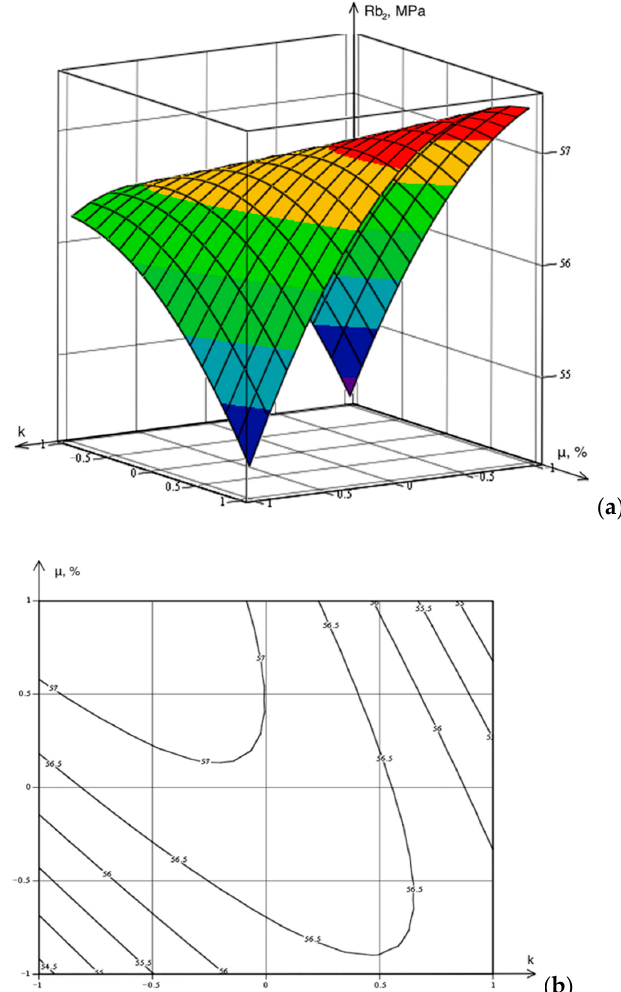
Figure 13. Dependence of the compressive strength of concrete reinforced with a combination of steel and polypropylene fiber ( a )—three-dimensional surface; ( b )—isolines.